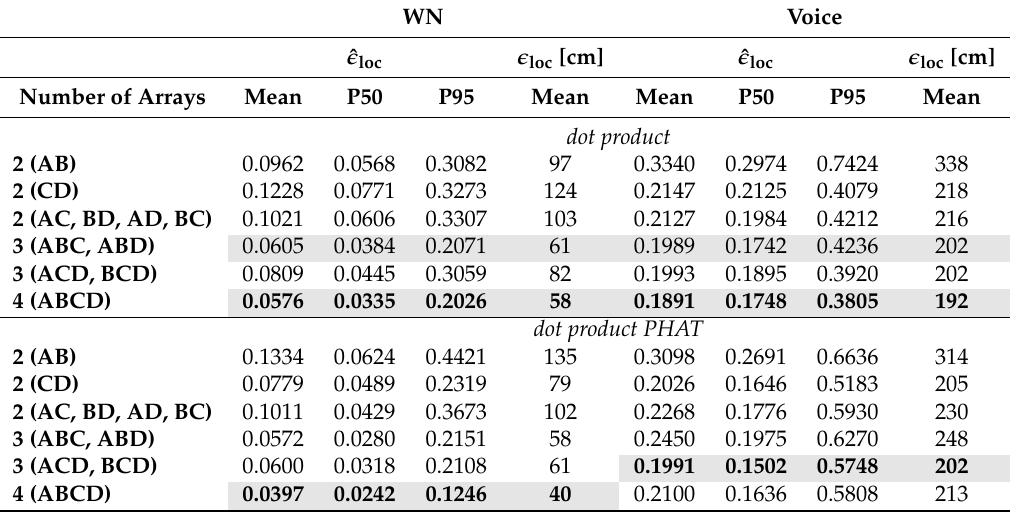
Table 5. ˆ (cid:101) loc and mean (cid:101) loc assessment of the matching algorithm for different array combinations, calculation methods and sounds. The highlighted rows list the best performing array combinations. WN Voice ˆ (cid:101) loc (cid:101) loc [cm] ˆ (cid:101) loc (cid:101) loc